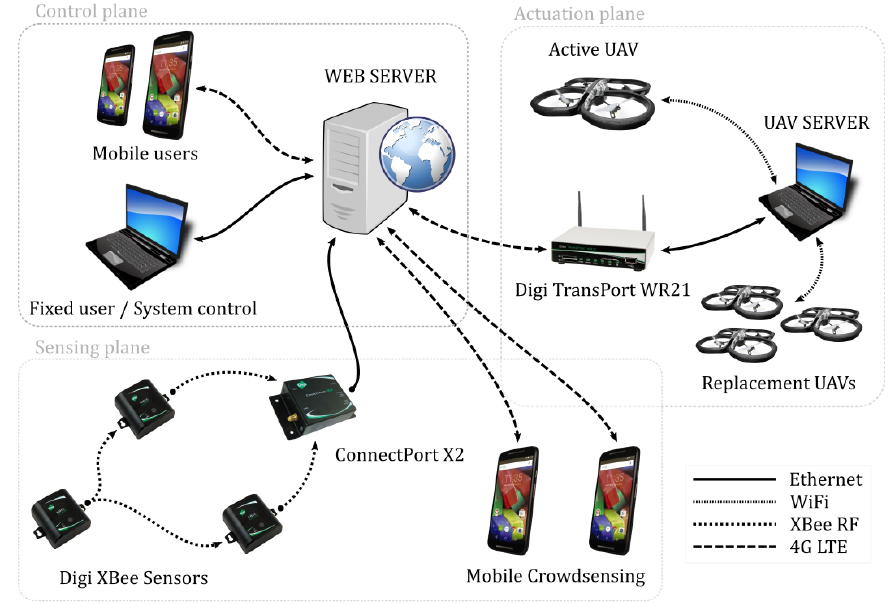
Figure 5. Functional description of the proposed